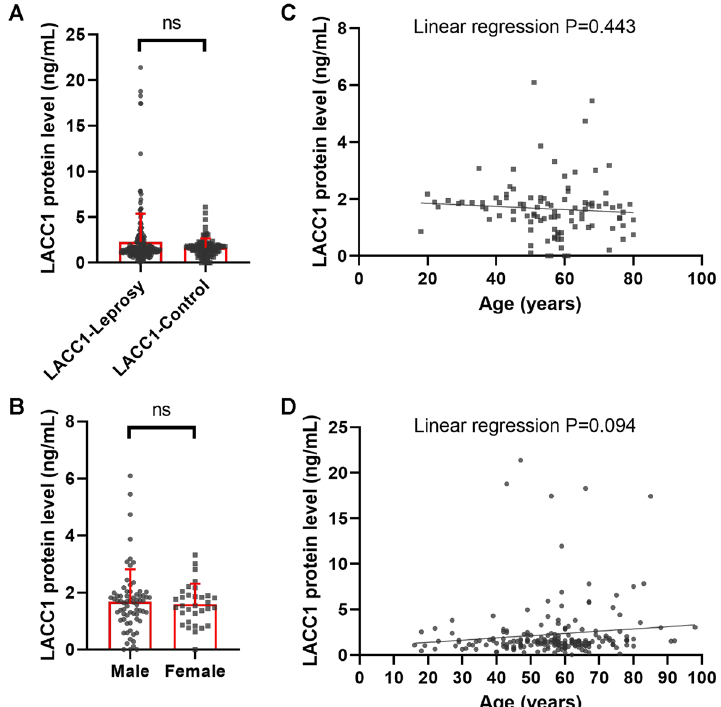
Figure 3. Circulating level of LACC1 protein in cured leprosy patients and controls. ( A ) Comparison of the LACC1 protein level (ng/ml) in plasma of cured leprosy patients with that of healthy controls. ( B ) Sex-specific level of LACC1 (ng/ml) in plasma of controls. ( C ), Alteration of the LACC1 protein (ng/ml) in plasma of controls along age (years). ( D ) Alteration of the LACC1 protein (ng/ml) in plasma of cured patients along age